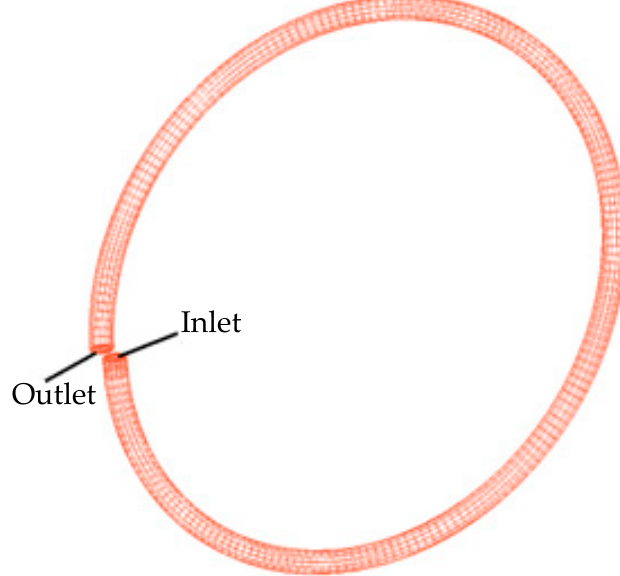
Figure 3. Computational grid of a unit of helical tube.